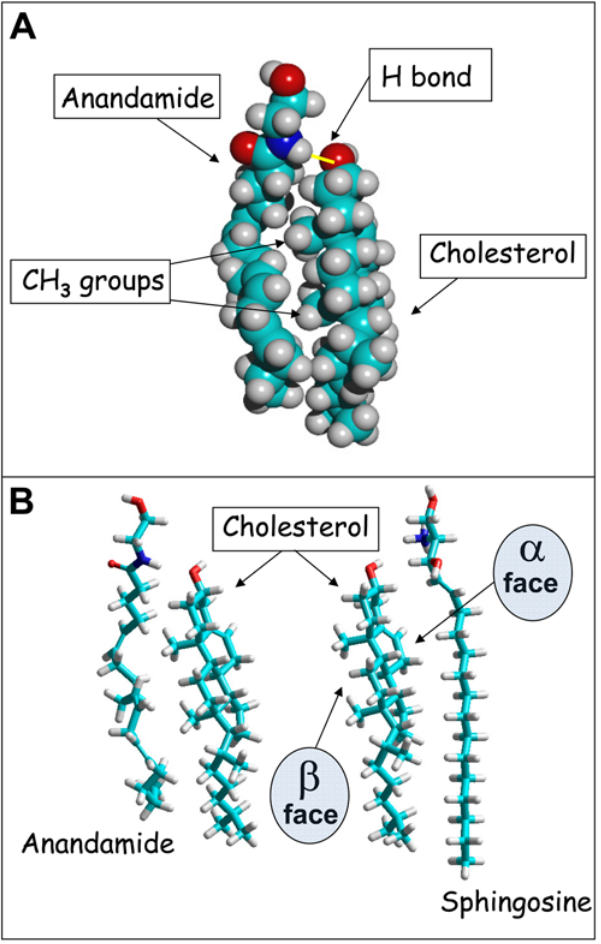
Figure 1. Molecular modeling of anandamide-cholesterol interactions. A- Spacefill model of a cholesterol-anandamide complex in vacuo obtained with the Polak-Ribiere algorithm (for geometry optimization) and then submitted to Monte Carlo simulations. The extended conformation of anandamide in membrane environments is consistent with the study of Tian et al. [4]. The methyl groups on the b face of cholesterol fit particularly well with the cavities generated by the double bonds of anandamide. The complex is stabilized by van der Waals interactions and a hydrogen bond (yellow) between the OH group of cholesterol (acceptor group) and the NH group of anandamide (donor group). The total energy of the system is 48.12 kcal.mol 2 1 ( 2 2.81 kcal.mol 2 1 for anandamide bound to cholesterol). B- Compar- ison of cholesterol-anandamide and cholesterol-sphingosine interac- tions. The cholesterol-anandamide complex (left panel) is the same as in (A), but shown in a tube representation. The cholesterol-sphingosine complex [13] is shown in the left panel. Note that sphingosine has a good geometric and chemical compatibility with the smooth a face of cholesterol. Anandamide reacts similarly with cholesterol but with its rough b face. The total energy of the system is 48.68 kcal.mol 2 1 for the cholesterol-sphingosine complex ( 2 2.41 kcal.mol 2 1 for sphingosine bound to cholesterol).